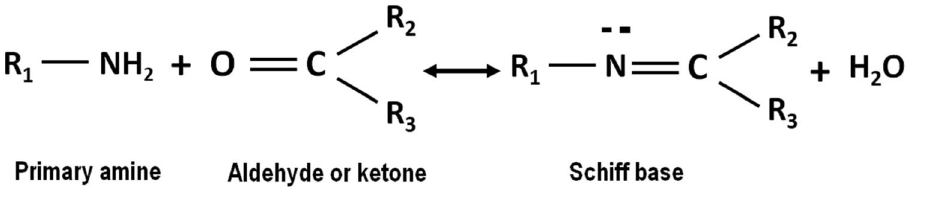
Figure 2. Shiff base